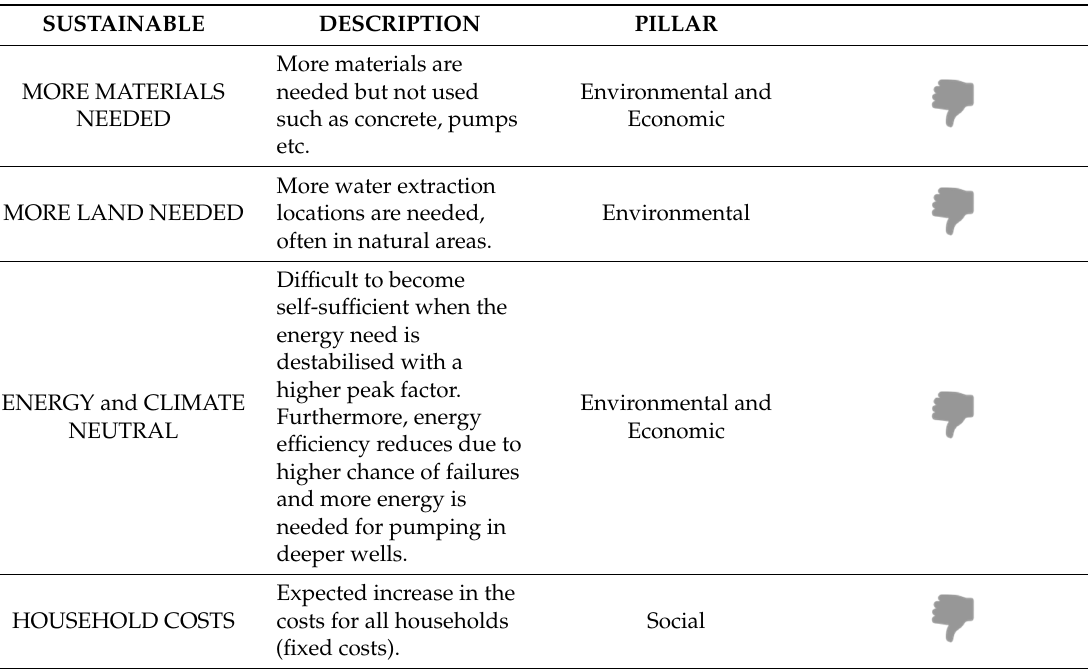
Table 7. Sustainability of centralised system in LF-extreme scenario.